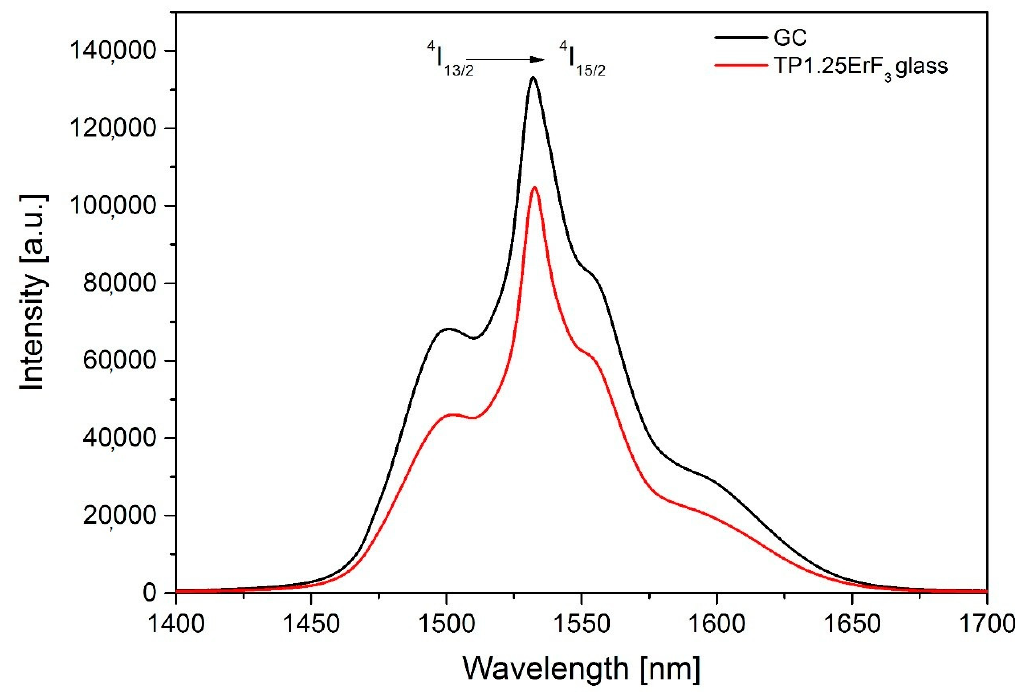
Figure 20. 1553 nm emission spectra of TP1.25ErF 3 glass and glass-ceramic.